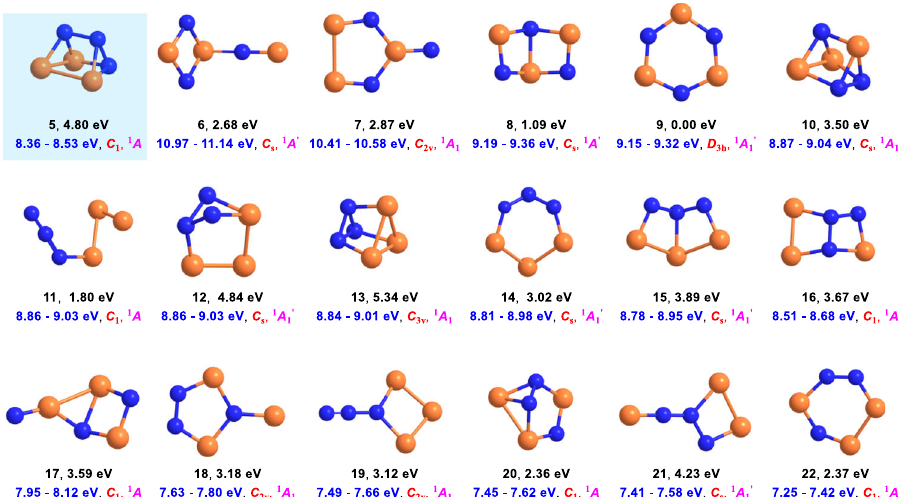
Fig. 2 Molecular structures of P 3 N 3 isomers. The structures were computed at the B3LYP/cc-pVTZ level of theory. Relative energies in eV (black), computed adiabatic ionization energies corrected for the electric fi eld effect (Stark effect) and computational errors (see Methods: Theoretical) (blue), point groups (red), and ground states (magenta) are also shown. The atoms are color coded in blue (nitrogen) and orange (phosphorous).